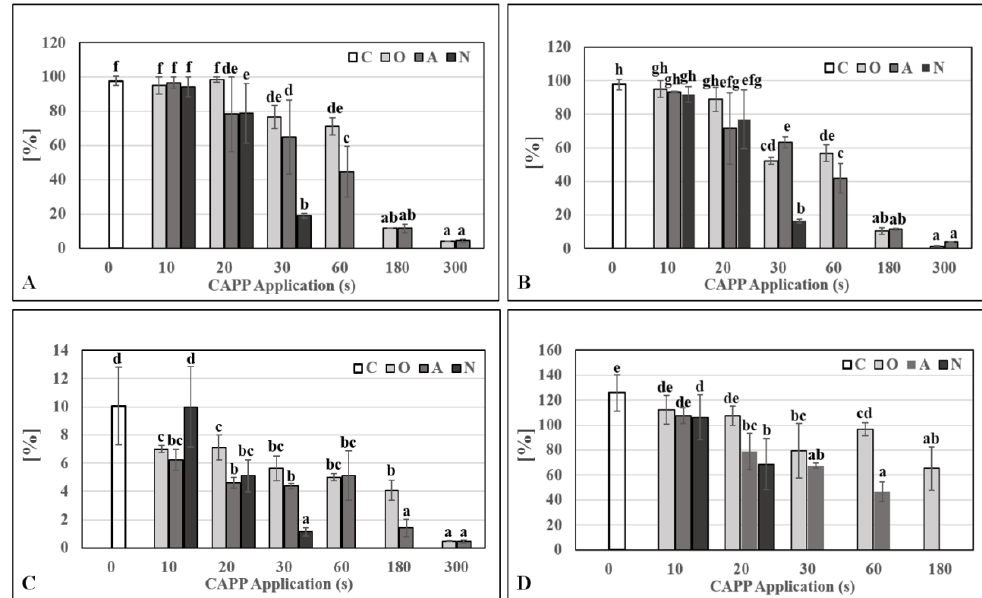
Figure 1. Germination (%) ( A ), Germination Potential (%) ( B ), Germination Index (%) ( C ) and Grain Vigor Index (%) ( D ) of barley grains after cold atmospheric pressure plasma (CAPP) treatment. Variants: C—control/untreated barley grains; O10–O300: barley grains treated with plasma generated in oxygen atmosphere for 10, 20, 30, 60, 180 or 300 s; A10–A300: barley grains treated with plasma generated in ambient air for 10, 20, 30, 60, 180 or 300 s; N10–N300 barley grains treated with plasma generated in nitrogen atmosphere for 10, 20, 30, 60, 180 or 300 s. Different letters indicate significant difference at p -value < 0.05, bars are means of ten experimental runs (one run represents 50 grains per variant, n = 500) ± SD according to Tukey’s HSD (Honestly Significant Difference) test. Indexes were calculated according to Abdul-Baki and Anderson [ 26 ] .